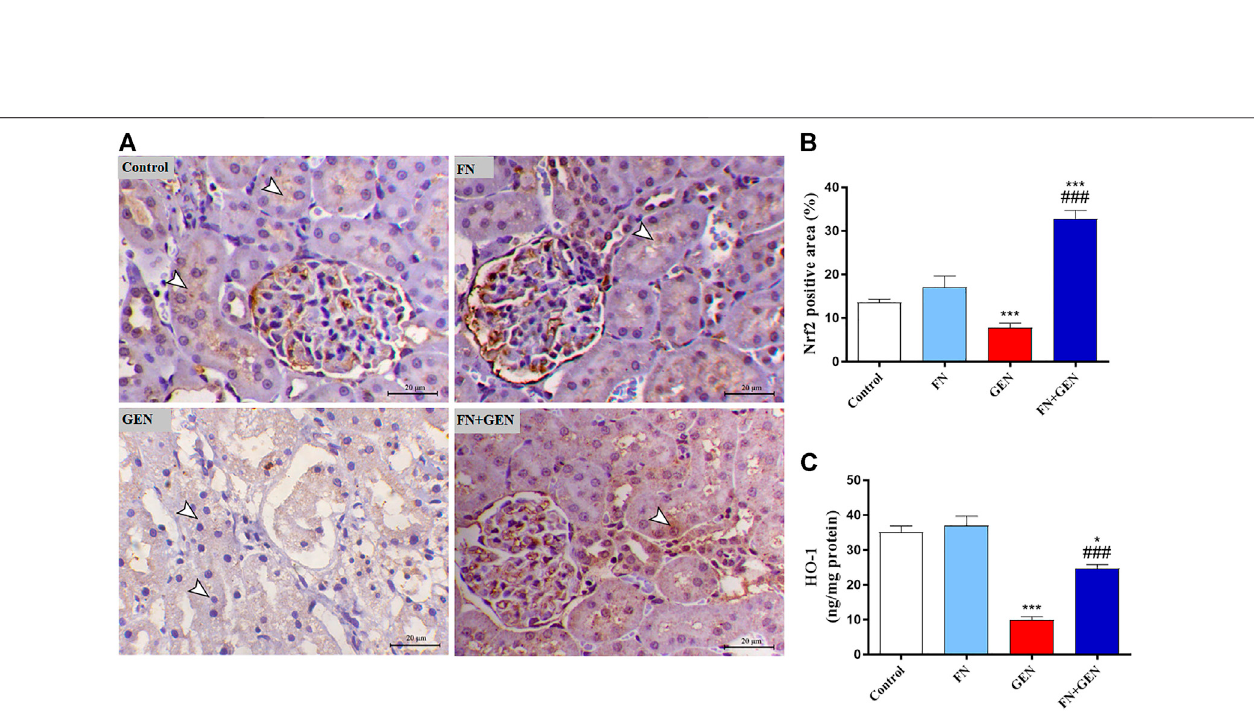
Frontiers in Pharmacology |